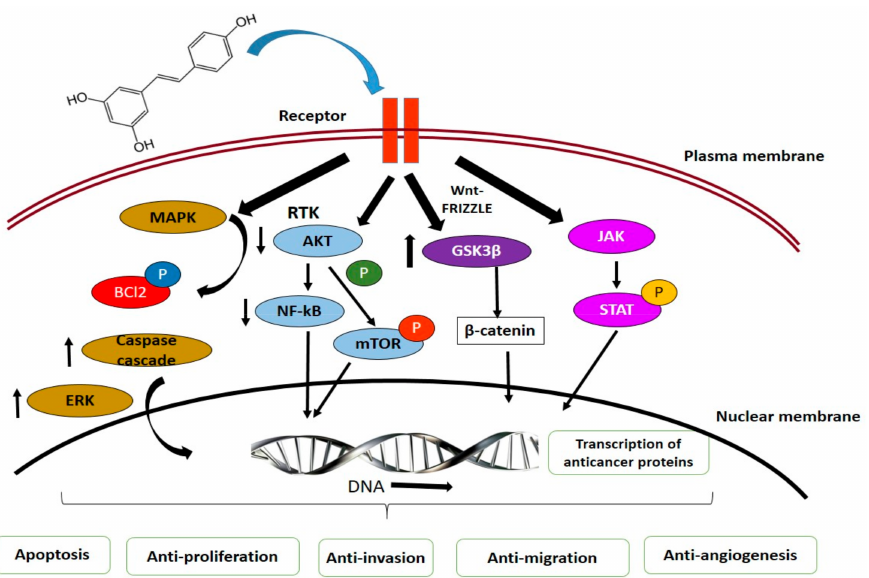
Figure 3. Interaction of phytochemicals with signaling molecules in cancer chemoprevention. Figure represents action of phytochemicals on MAPK, Akt, Wnt, and JAK/STAT pathways inducing cancer cell death through activation of several internal signaling